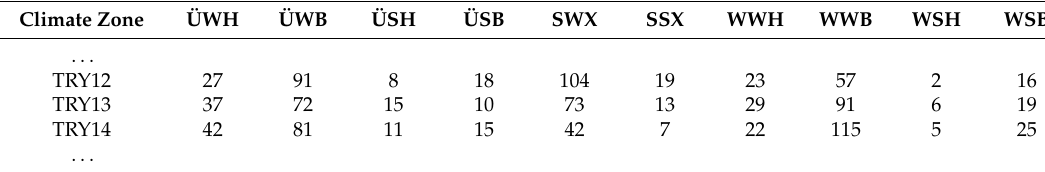
Table 2. Test reference years according to VDI 4655 (excerpt)